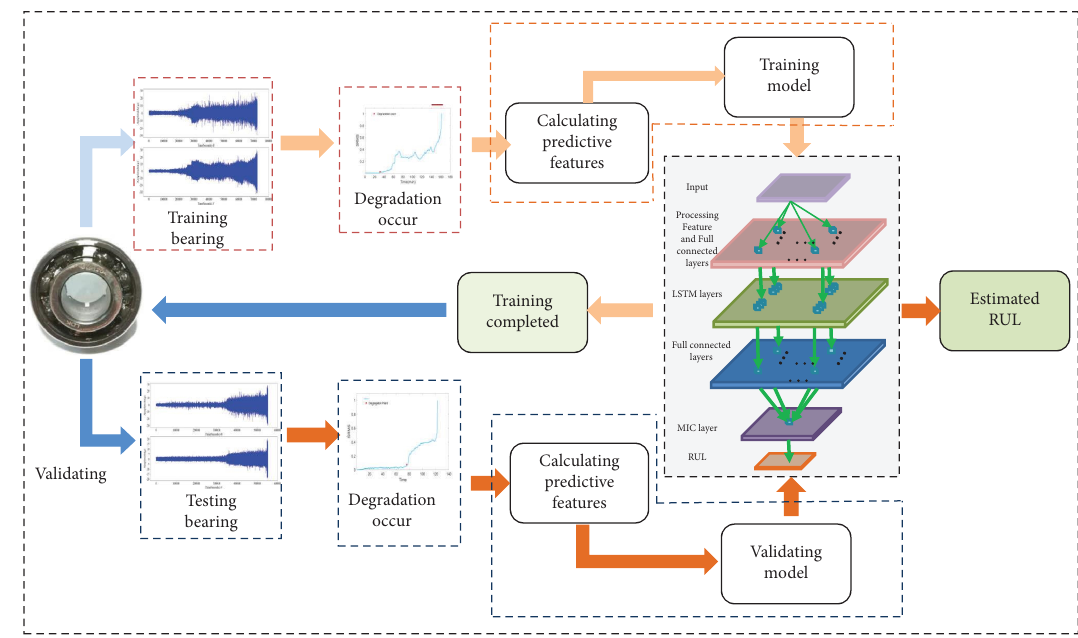
Figure 5: Te procedure of EDLSTM prognosis RUL for rolling